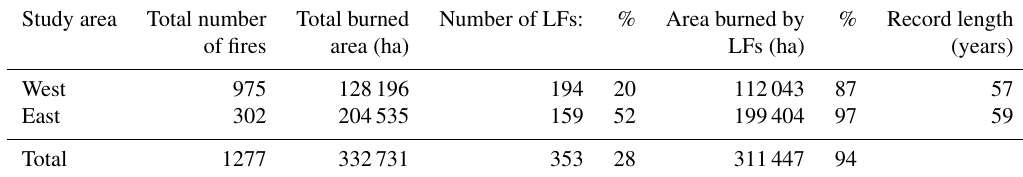
Table 1. Statistics on fires ( ≥ 1ha) and LFs ( ≥